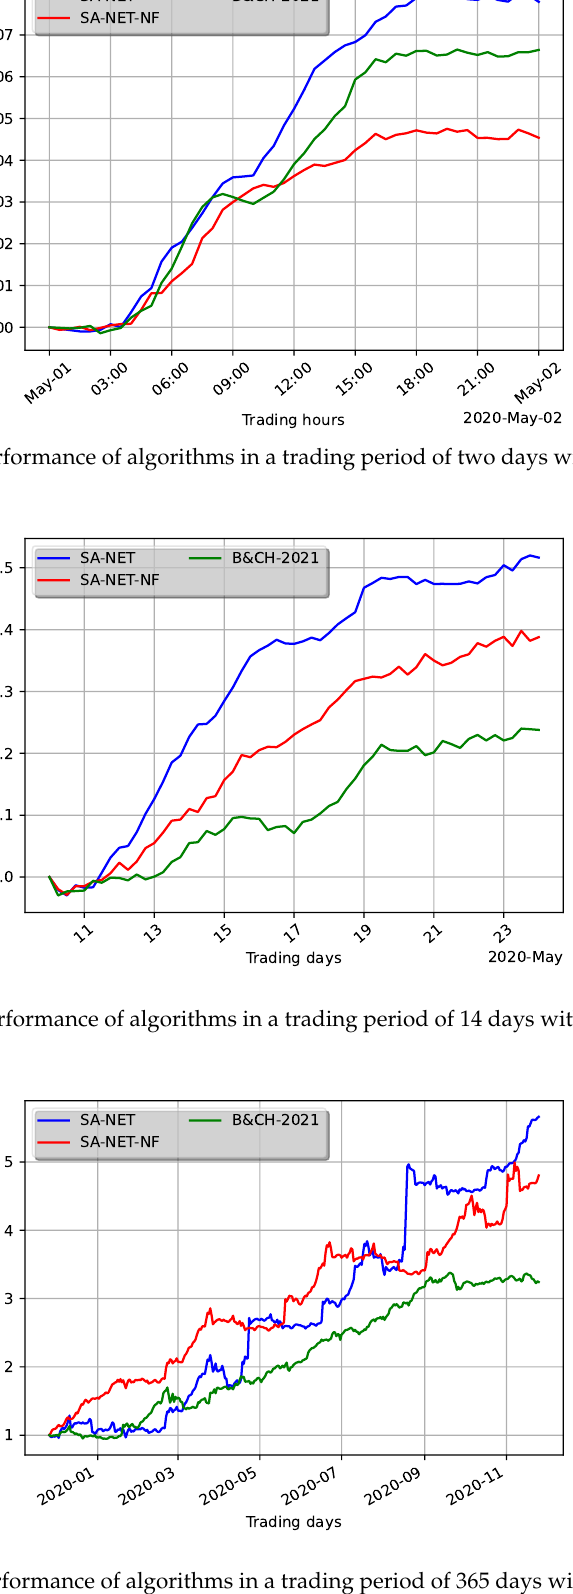
( c ) Performance of algorithms in a trading period of 365 days with trading intervals of one day. Figure 10. Performance of three competing algorithms in trading episodes with different